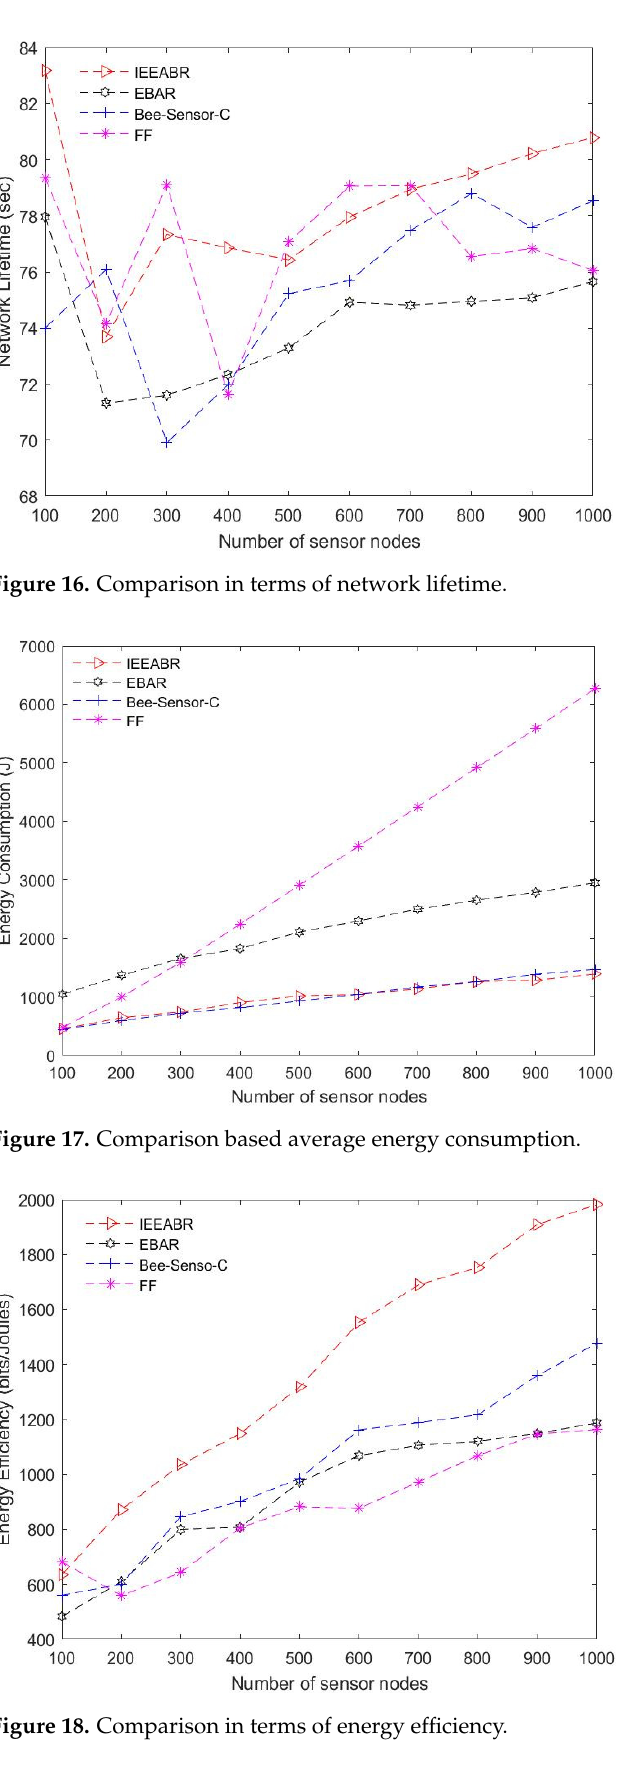
Figure 18. Comparison in terms of energy efficiency.